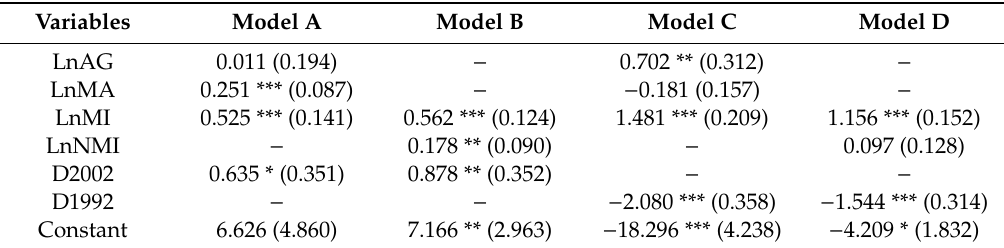
Table 9. Long − term coe ffi cients based on fully modified ordinary least square (FMOLS). Variables